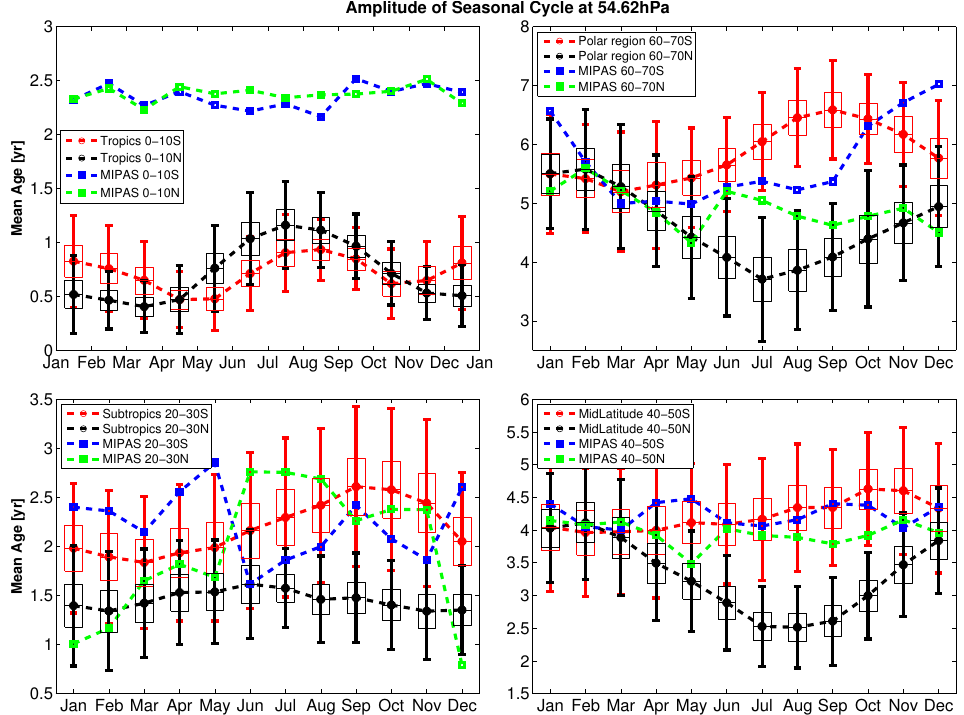
Fig. 10. Amplitude of the seasonal cycle of the mean age over 22yr at 20km height in the inner tropics (upper left: 0–10 ◦ S and N), in the subtropics (lower left: 20–30 ◦ S and N), in the mid-latitudes (lower right: 40–50 ◦ N and S) and the polar regions (upper right: 60–70 ◦ N and S) compared with the age derived from SF 6 MIPAS data.(Red and blue): Southern Hemisphere for model and SF 6 ages, respectively. (Black and green): same for Northern Hemisphere. The error bars show the standard deviation of the monthly ages and the boxes show the 90% confidence interval of the mean age.